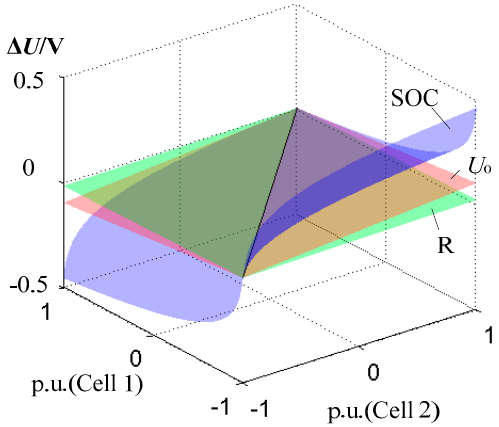
Figure 2. The influence of parameters. Table 1. The standard unitary values of the parameters.